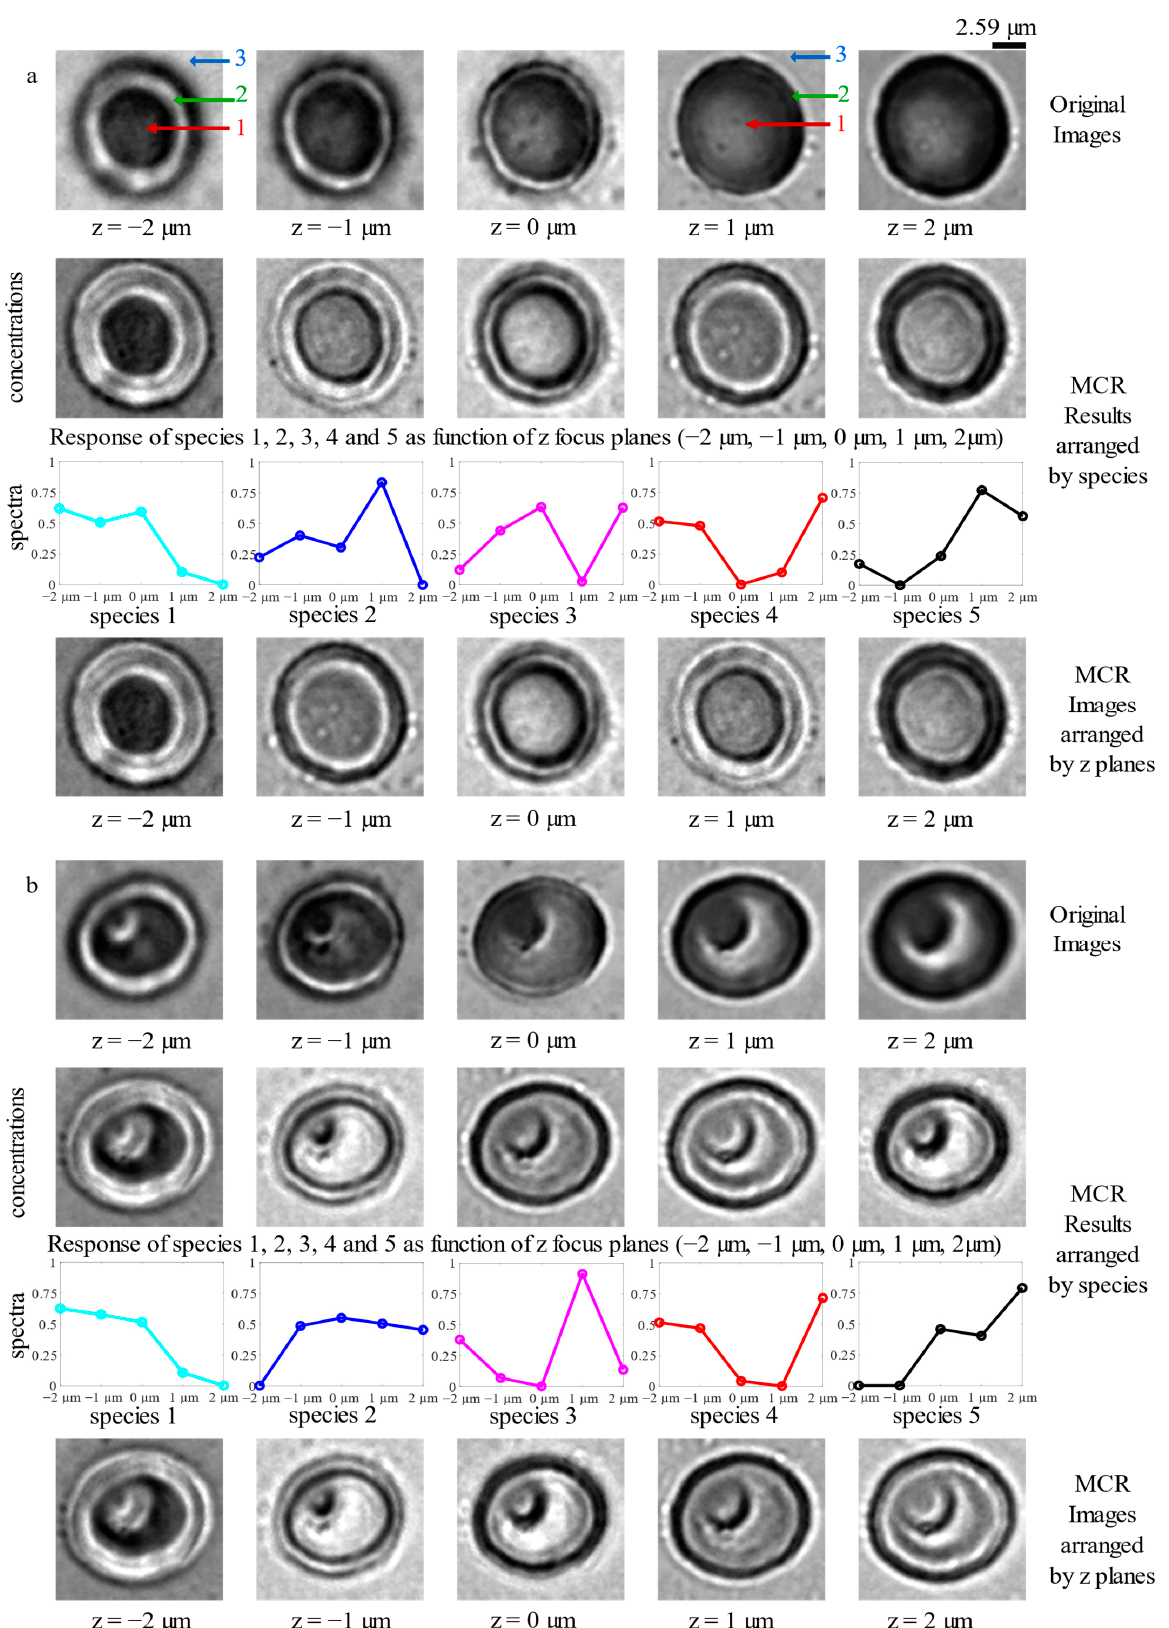
Figure 3. Pre-processed brightfield microscope images and results from MCR analysis for assumed- to-be-healthy erythrocyte ( a ) and an erythrocyte with a suspected infection ( b